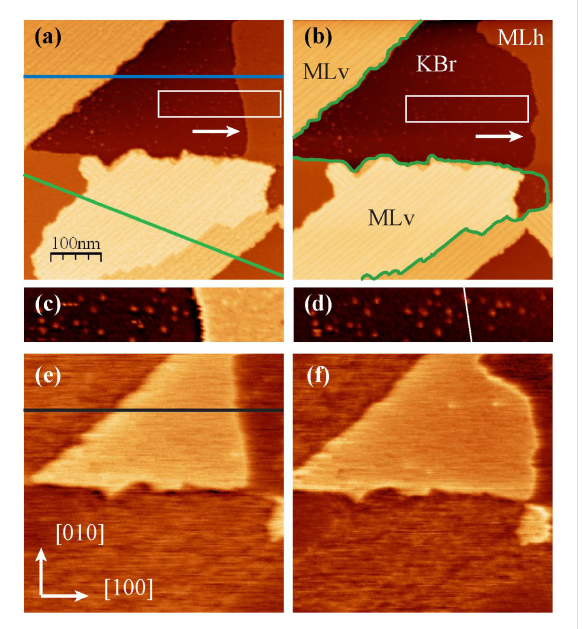
Figure 4: Images of a sample annealed at 150 °C after the deposition of the molecules at room temperature. (a) and (b): topographic images, (c) and (d): enlargement of the areas marked by a white rectangle on (a) and (b); (e) and (f): Kelvin maps obtained simultaneously with (a) and (b). (b), (d) and (f) were measured on the same area as (a), (c) and (e) after a time lapse of 13 h. Imaging conditions: Δ f = − 20 Hz, A = 2 nm. Two KBr monoatomic steps are outlined in green in